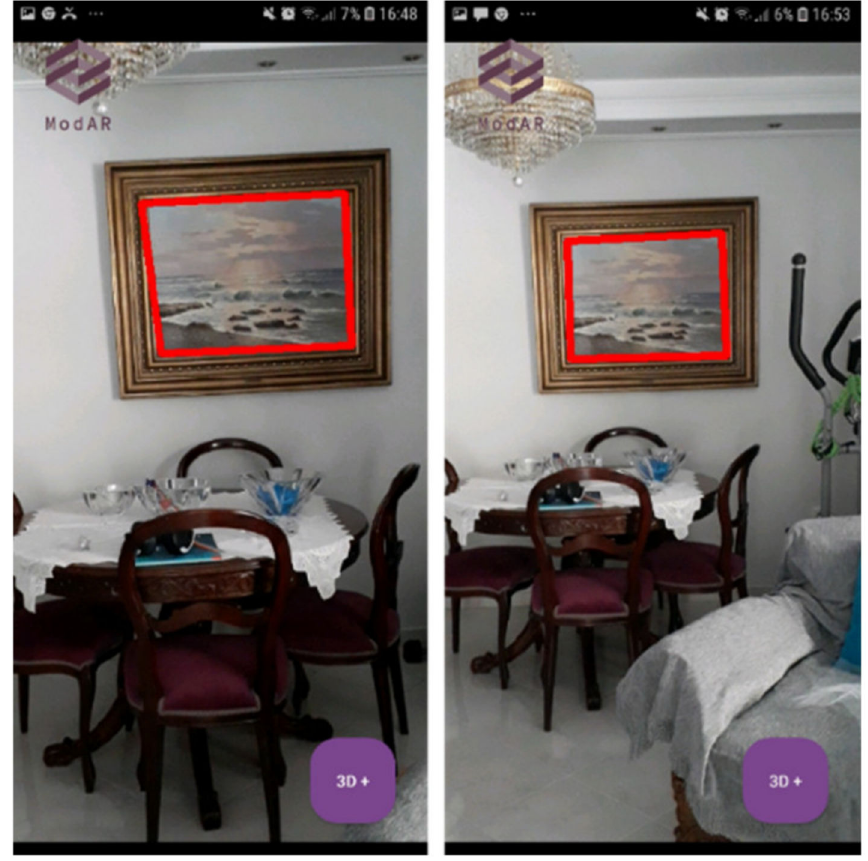
Figure 8. Screenshots from the ModAR prototype illustrating the minimum pattern scale for which successful pattern recognition is achieved for FAST-ORB-2000 ( left ) and AGAST-BRISK-3 ( right